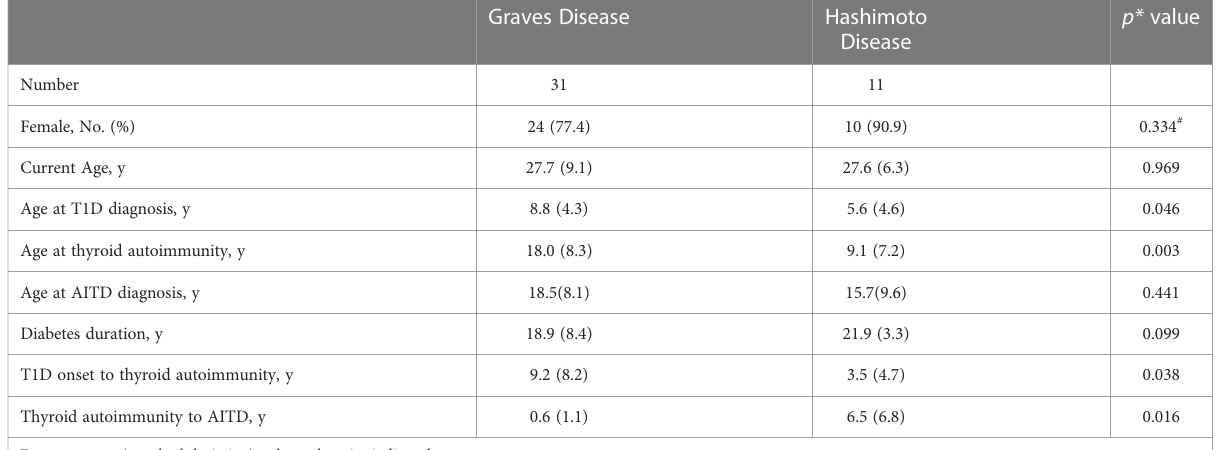
TABLE 3 Comparison between patients with Graves disease and those with Hashimoto